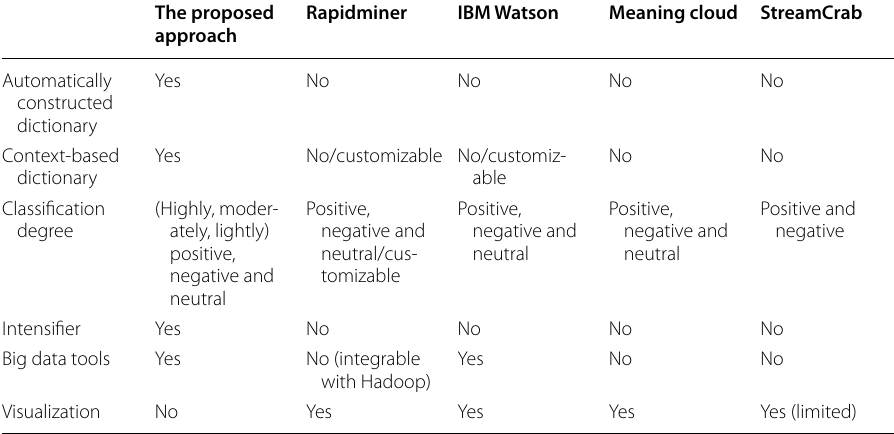
Table 6 Comparison with other sentiment analysis tools